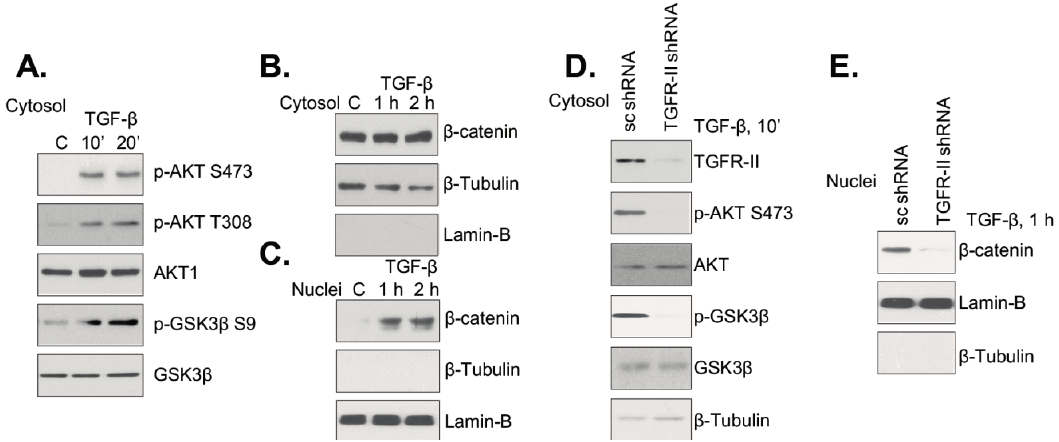
Figure 2. TGF- β receptor-II is required for TGF- β 1-induced Akt/GSK3 β phosphorylation and β -catenin nuclear translocation. Mouse PSCs (Day 4) were treated with TGF- β